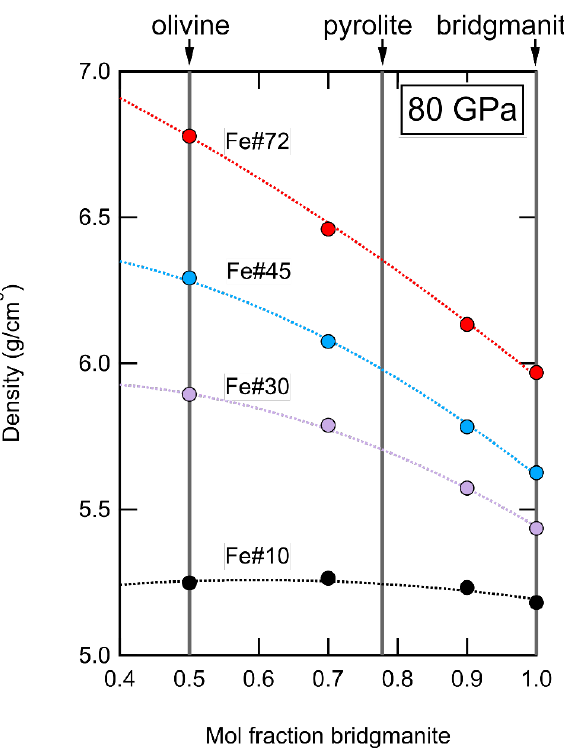
Figure 7. At 80 GPa, modeled densities of lower mantle phase assemblages comprising ferrous-iron-bearing bridgmanite and ferropericlase. Model compositions (symbols) vary in mol% bridgmanite and bulk iron content. The % bridgmanite marked “pyrolite” corresponds to the pyrolite Mg/Si ratio, but does not address other elemental abundances in pyrolite (e.g., Al and Ca). Dotted lines for constant bulk Fe# are provided as guides to the eye.